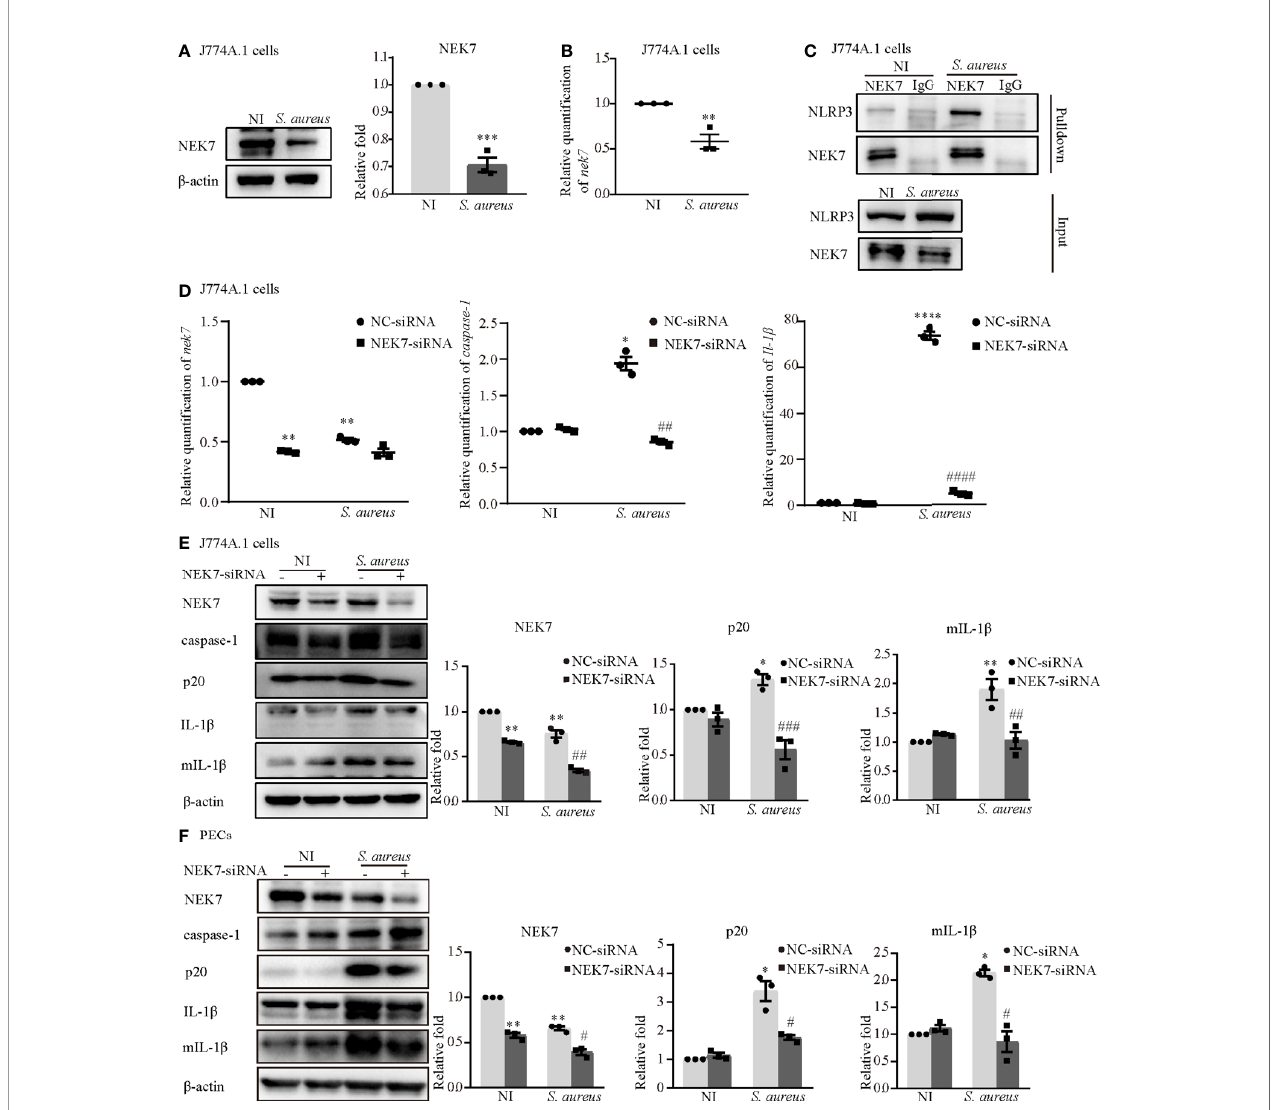
FIGURE 2 | NEK7 was vital in S. aureus infection-induced NLRP3 in fl ammasome activation. The J774A.1 cells were infected with S. aureus (MOI of 1) for 24 h. (A) The protein expression level of NEK7 were detected by western blot and analyzed by relative densitometric quanti fi cation. (B) The mRNA expression level of nek7 were detected by RT-PCR. (C) The NEK7-NLRP3 ineraction were detected by coimmunoprecipitation. (D) Cells were pretreated with or without NEK7-siRNA for 48 h. The mRNA expression levels of caspase-1 , Il-1 b and nek7 were examined by RT-PCR. (E, F) The protein expression levels of caspase-1, p20, pro-IL-1 b , mIL-1 b and NEK7 were detected by western blot in J774A.1 cells (E) and PECs (F) and analyzed by relative densitometric quanti fi cation. Similar results were obtained in three independent experiments in data. Data shown are means ± SEMs; * P < 0.05, ** P < 0.01, *** P < 0.001, **** P < 0.0001 vs . non-infection control group, # P < 0.05, ## P < 0.01, ### P < 0.001, #### P < 0.0001 vs . infection control